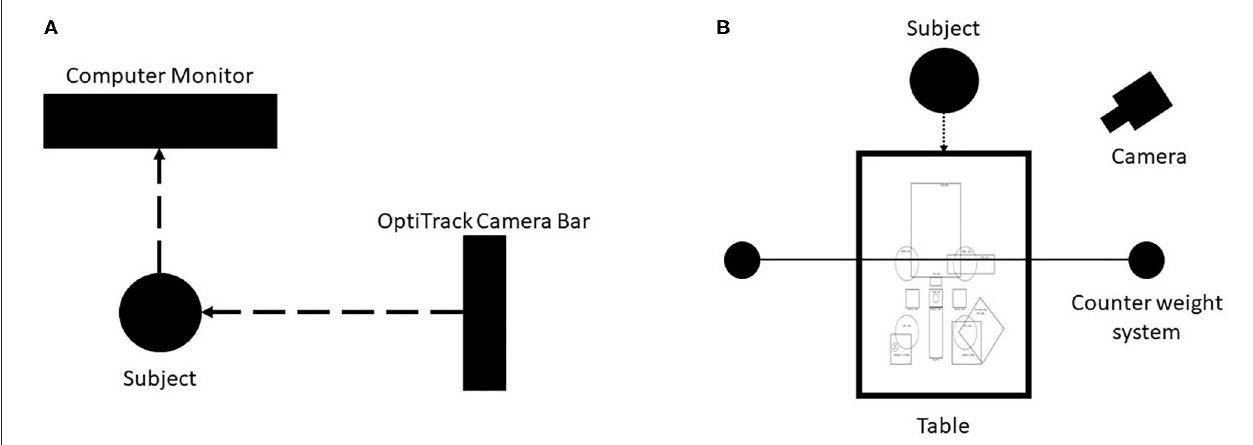
FIGURE 3 | Virtual reality (VR) and real-world (RW) experiment setups. (A) VR setup: Subjects were seated in front of a computer monitor, and a motion capture camera was placed to their right. The height and placement of the camera was adjusted to allow subjects to interact with the virtual table. (B) RW experimental setup. The subject sat in front of the table with a camera to their left to capture their performance for later review. A template was placed on the table to match where the objects would appear in the virtual environment. A counter-weight system was used to offset the torque placed on the subject’s arm by the DEKA Arm bypass